Question: Identify the chart type used in this figure.
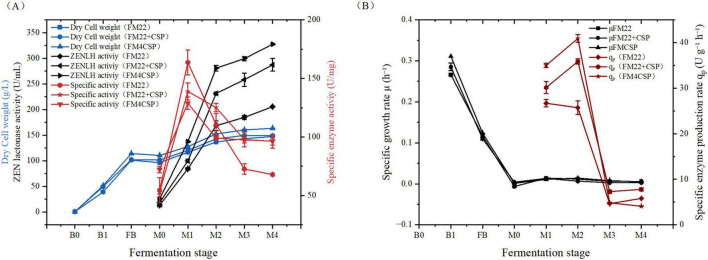
Answer: line